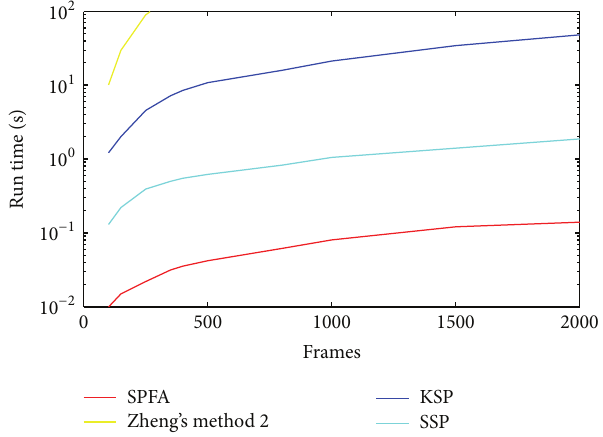
Figure 13: The comparison of run